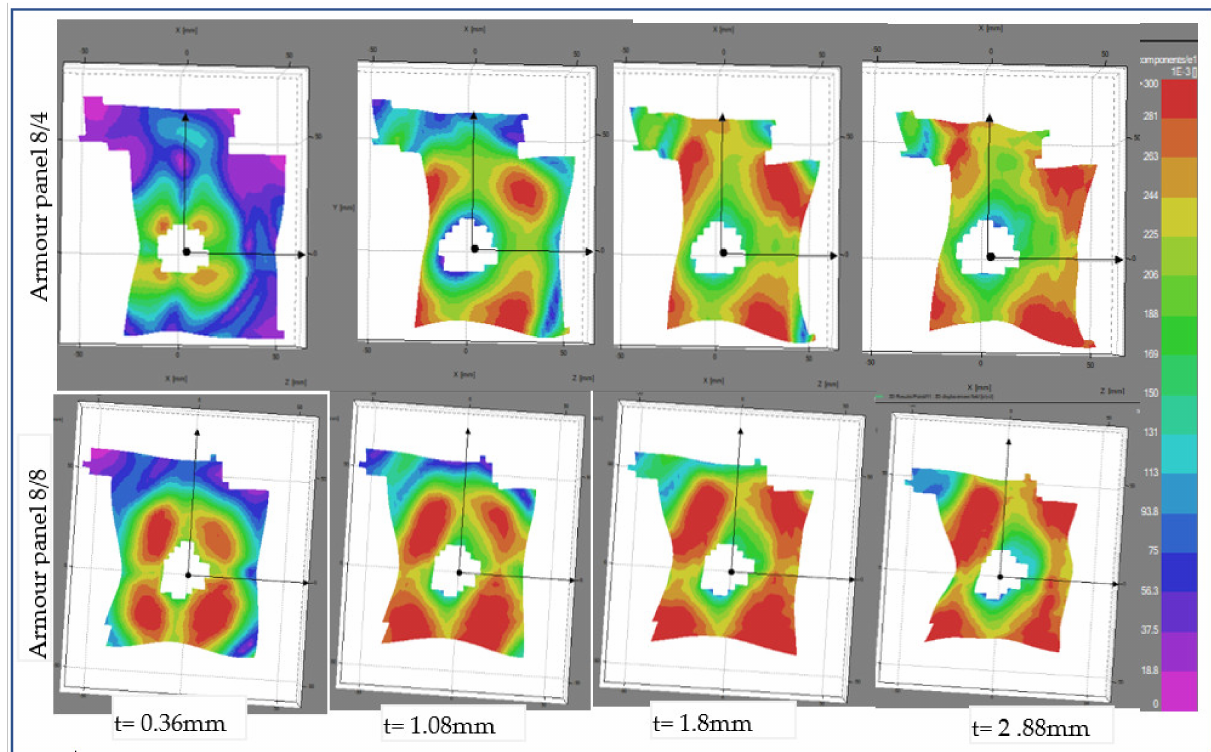
Figure 12. Frontal stereoscopic images sequences of an impacted armour panel selected impact timing at shot